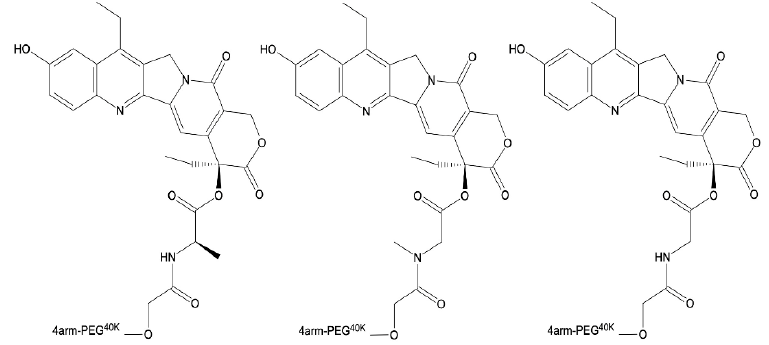
Figure 7. The structures of the conjugates of SN-38 and PEG-4000.